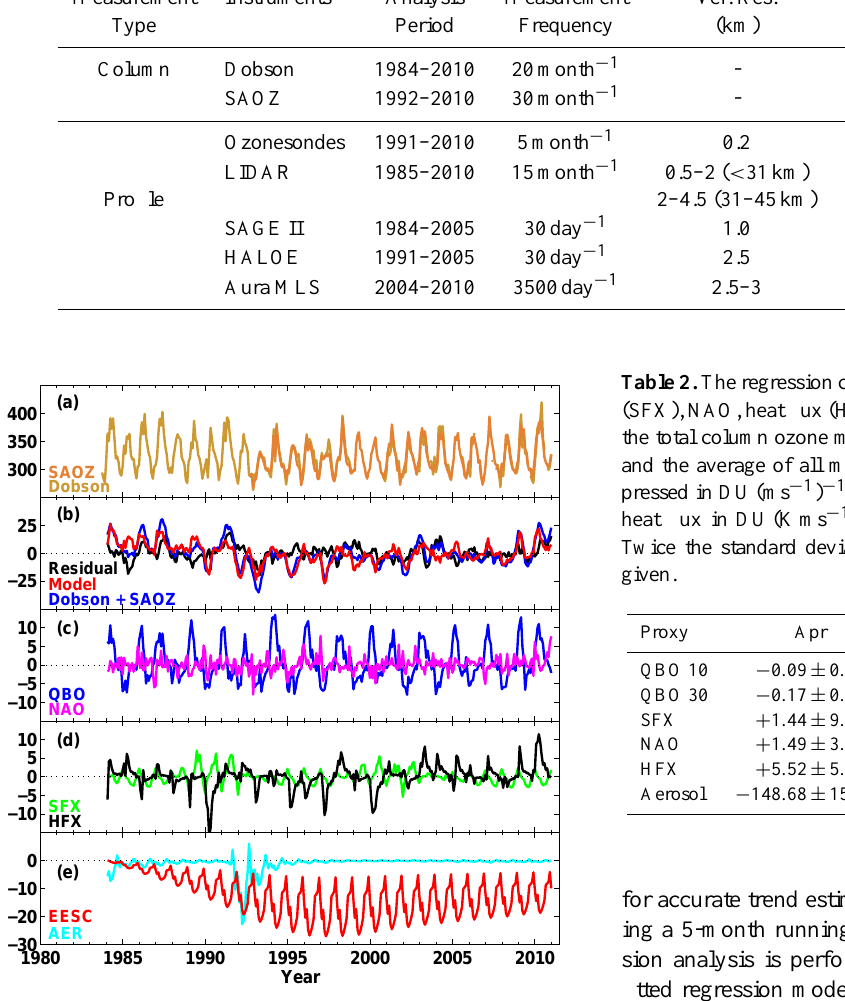
Table 1. The different instruments used for the analysis along with the analysis period, frequency of ozone measurements, vertical resolution (Ver. Res.), measurement range and the latitude and longitude bands (Lat., Long.) chosen for the satellite instruments to find the profiles near OHP (43.93 ◦ N, 5.71 ◦ E). Measurement Instruments Analysis Measurement Ver. Res. Measurement Lat., Long. Type Period Frequency (km) Range (km) ( ◦ N; ◦ E) Column Dobson